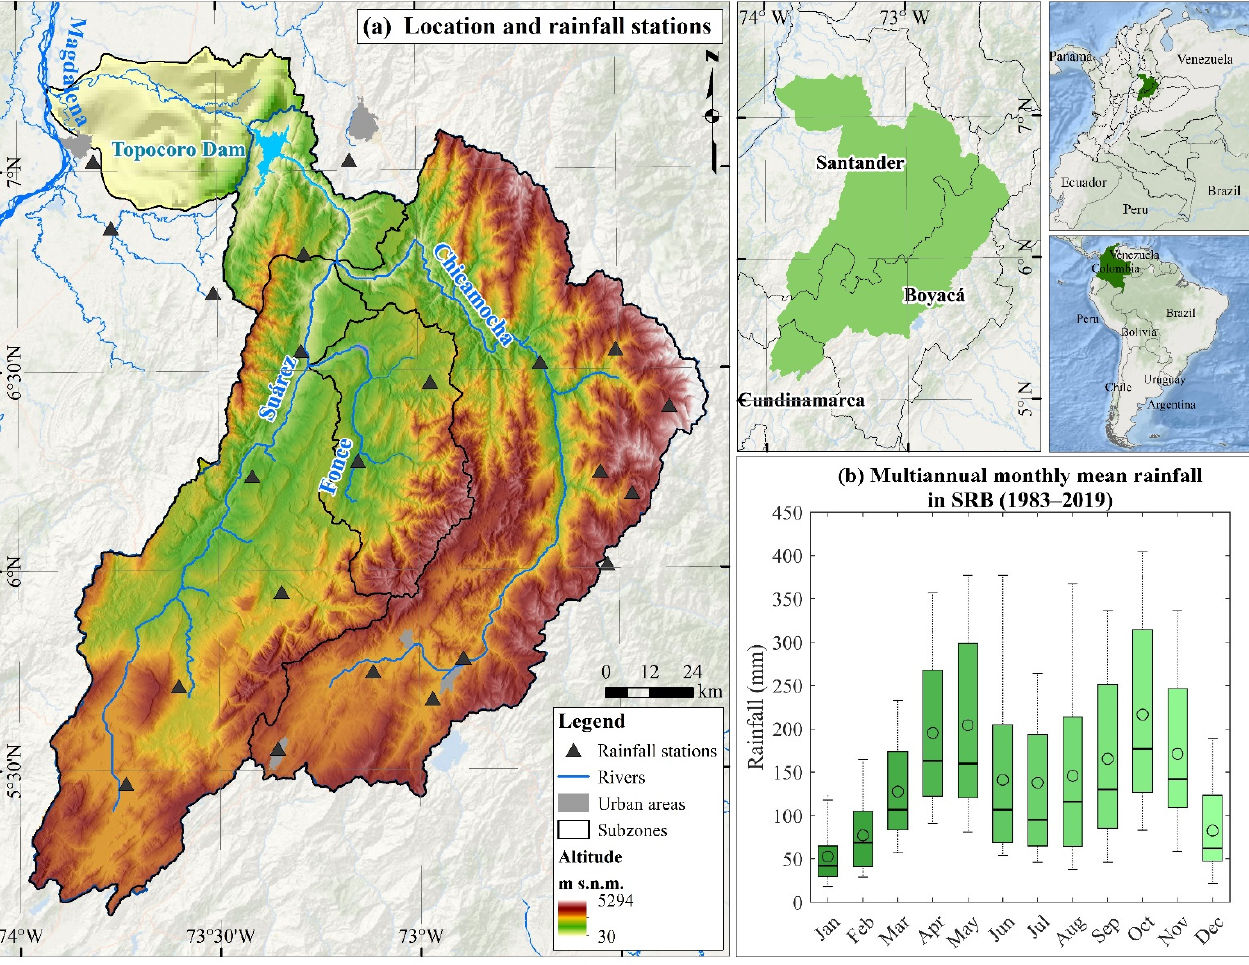
Figure 1. ( a ) Sogamoso River Basin (SRB) location and rainfall stations. ( b ) Annual cycle of monthly mean rainfall in the SRB for the 1982–2019 period based on the annual cycle of the 23 stations under study.